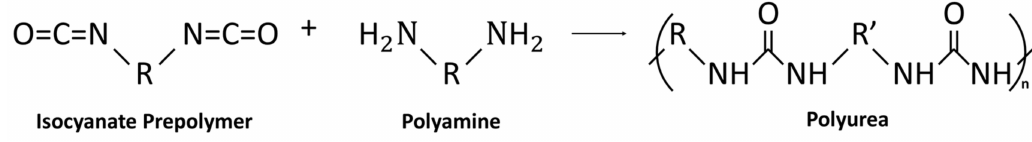
Figure 3. Polyurea reaction